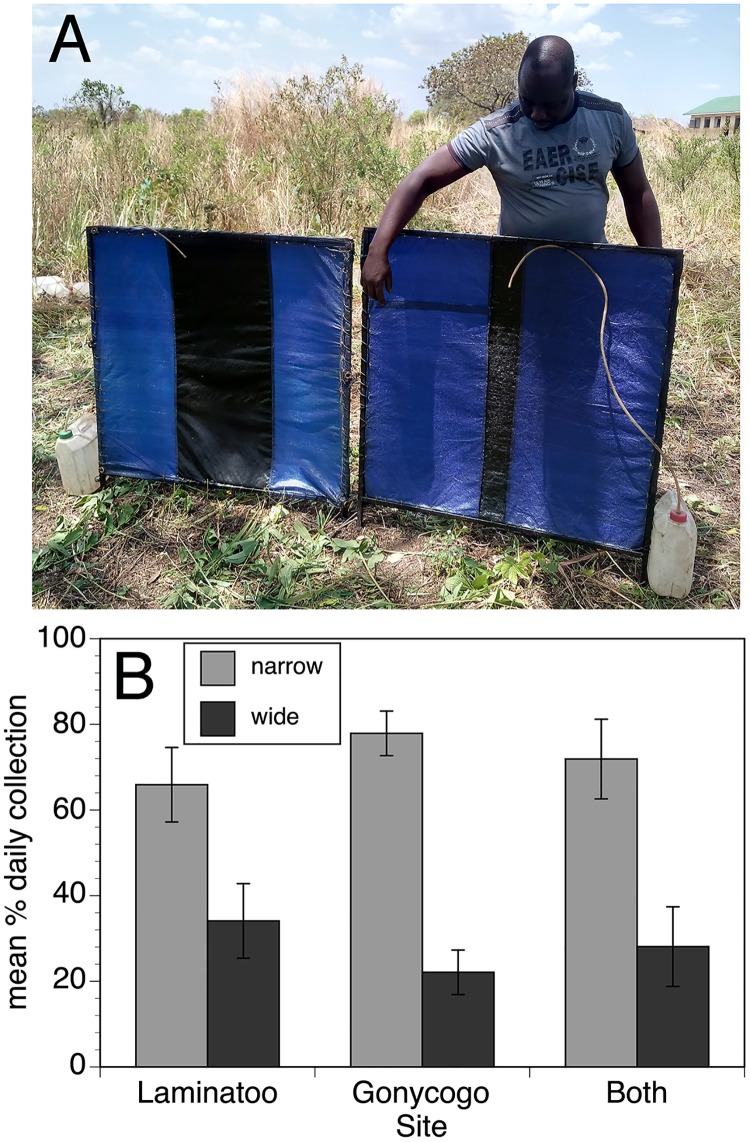
Relative performance of 1m traps with wide and narrow black stripes.Panel A: Photograph of the wide and narrow striped designs. Panel B: Relative performance of the wide and narrow striped trap designs in Laminatoo, Gonycogo and data from both communities combined. Data are presented as the mean percentage of the total collection by day, normalizing for variations in the absolute number of flies collected on each day, as described in Materials and Methods. Error bars indicate the standard deviation associated with the means. The analysis was conducted on data collected from 12 paired trials each in Laminatoo and Gonycogo. Raw collection data for this study may be found in the S3 Table.